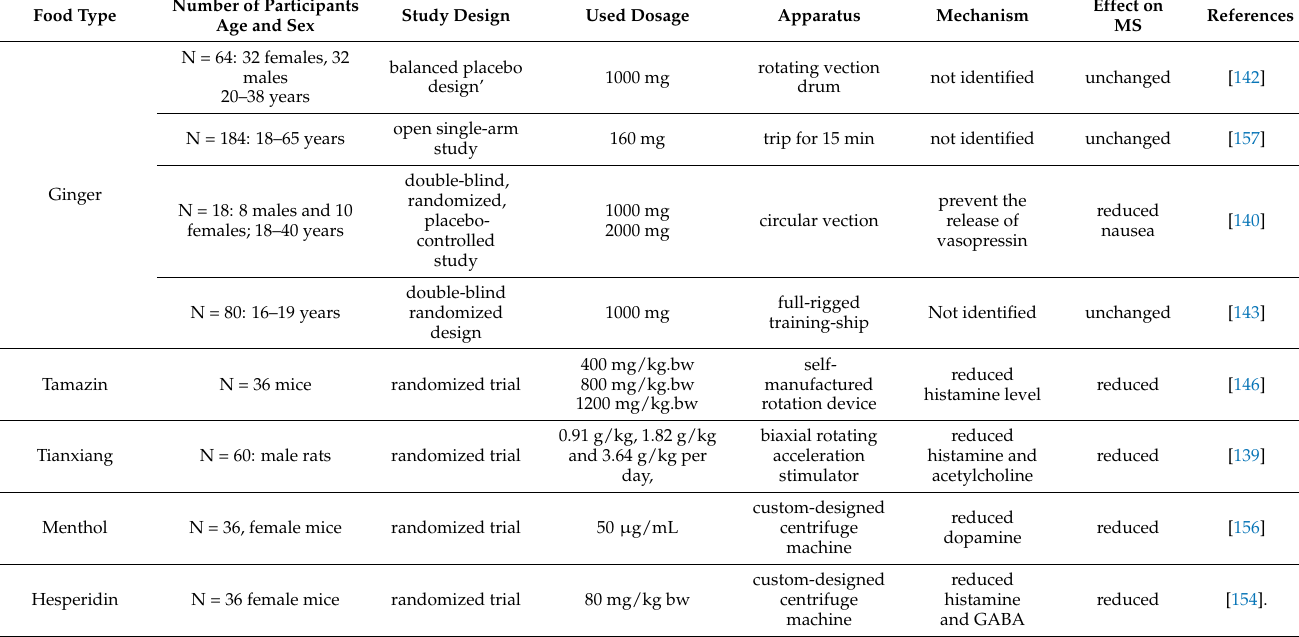
Table 2. Effect of different food consumption in a real and virtual environment and their impact on